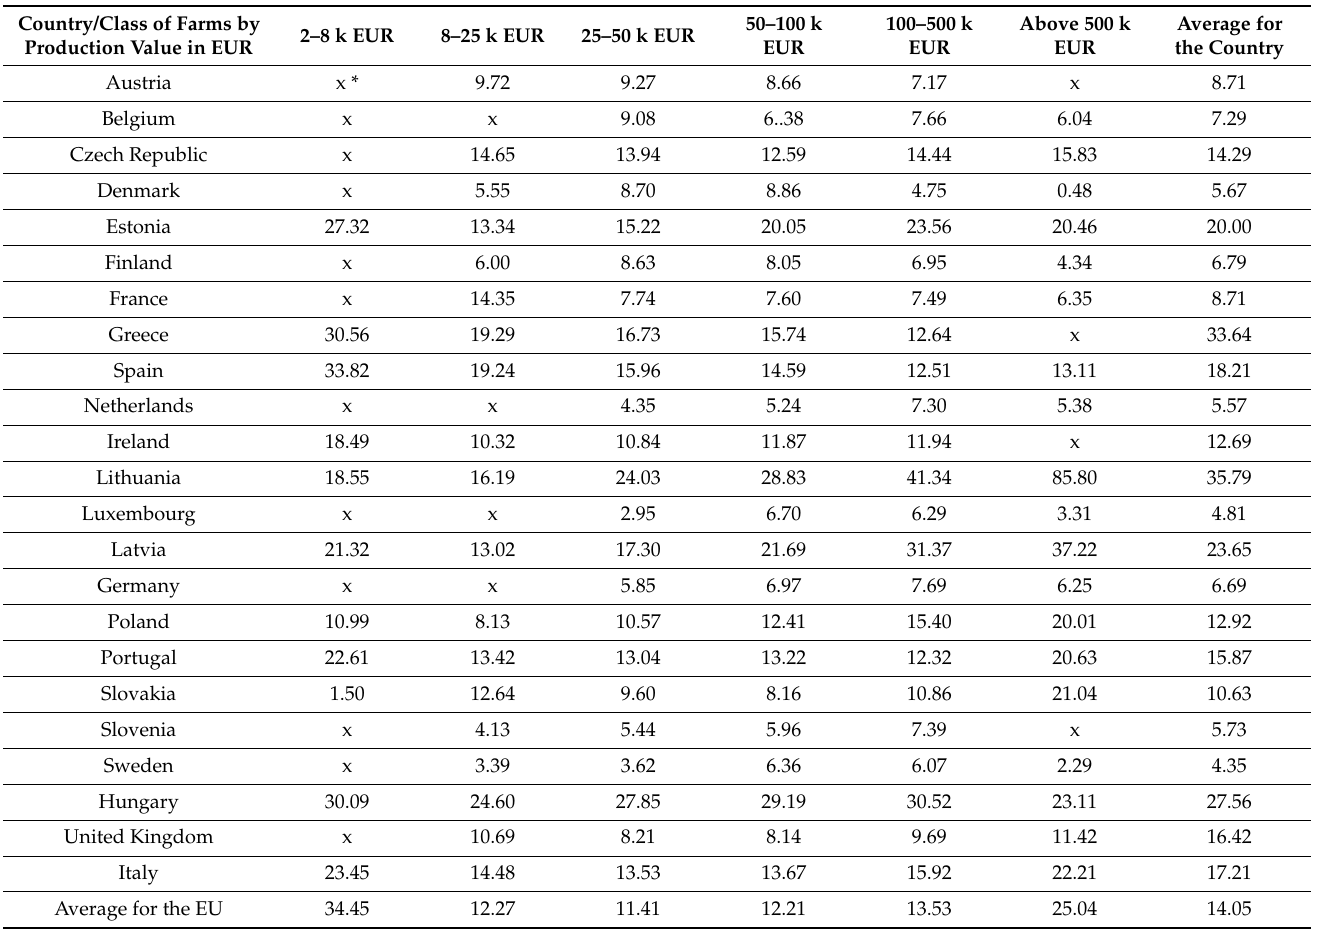
Table 1. Relationship of family farm income per full-time employee of families in various classes of farms by production value to non-farm income (in%, average for 2004–2017). Country/Class of Farms by Production Value in